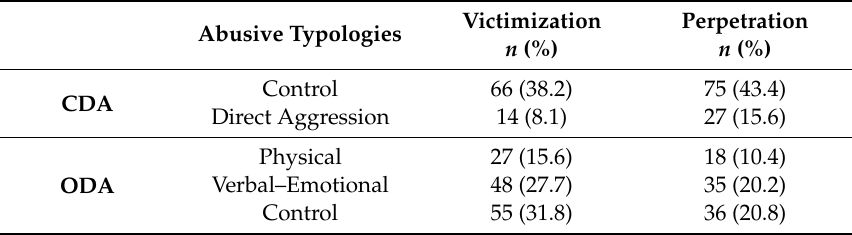
Table 2. Prevalence of cyber dating abuse (CDA), o ffl ine dating abuse (ODA) and related typologies ( n =